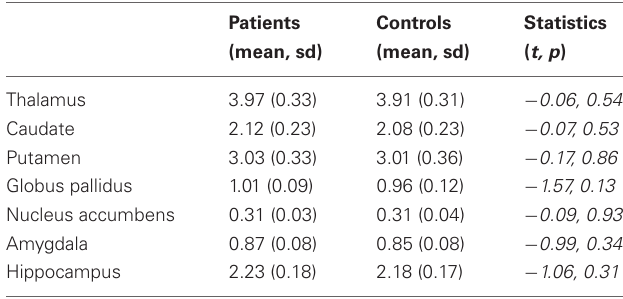
Table 2 | Volume of subcortical structures in tinnitus patients and control